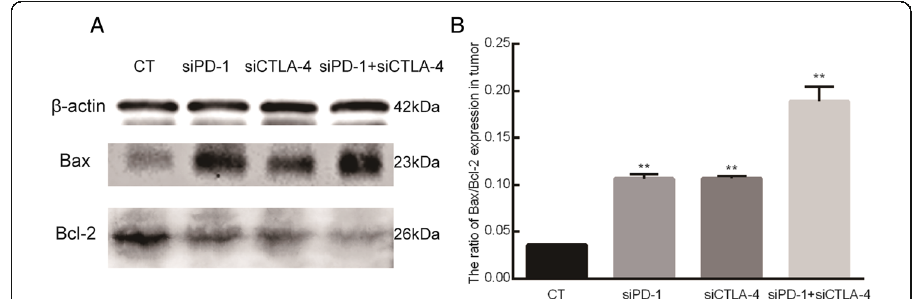
the western blot gels for the four tumor samples. CT = control, siPD-1 = group injected with siRNA for PD-1, siCTLA-4= group injected with siRNA for CTLA-4, siPD-1 + siCTLA-4= group injected with siRNA for PD-1 + Bax-to-Bcl-2 ratio significantly increased in all siRNA groups (** p < 0.01, * p <